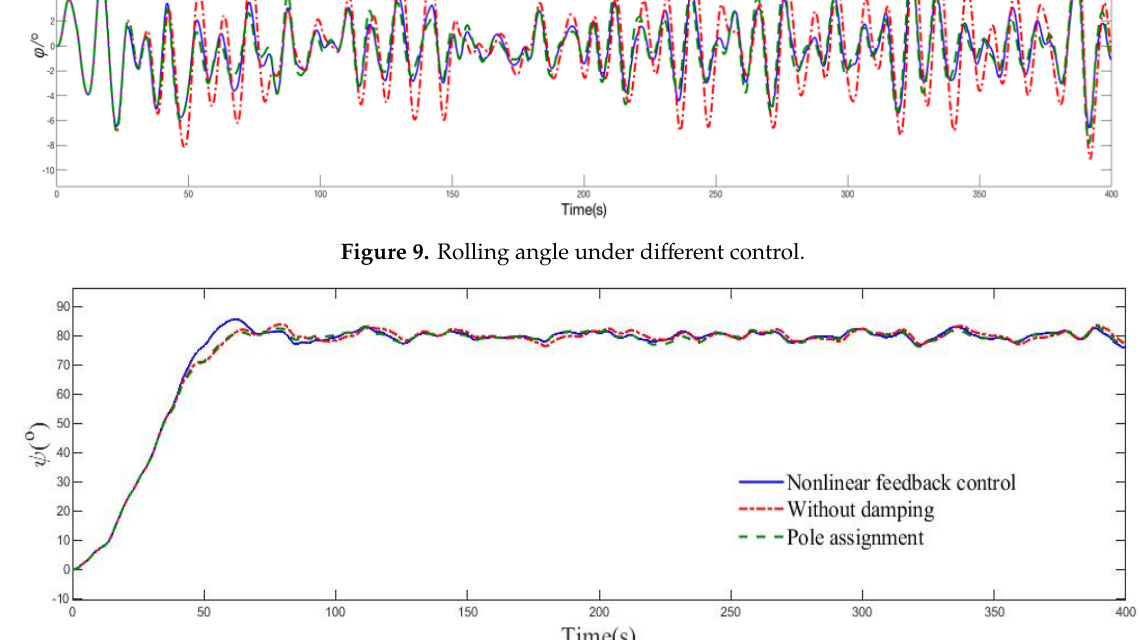
Figure 10. Course keeping under different control.